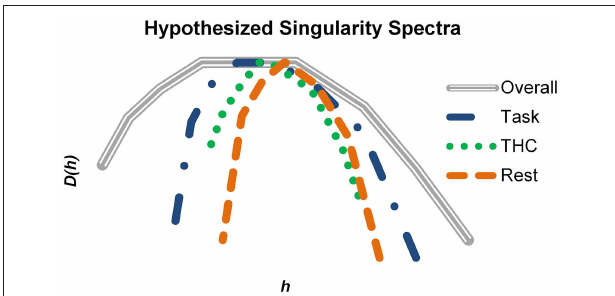
FIGURE 10 | Summary of how multifractal complexity relates to memory processing. Hypothetical singularity spectra were constructed based on the qualitative results of the study. The gray spectrum represents the maximal amount of multifractal complexity possible in a system (i.e., hippocampal spike trains in this example). Active memory processing recruits a large portion of this potential, but additional resources are still available to support more cognitively demanding instances. THC impaired working memory and reduced multifractal complexity. During resting conditions, the singularity spectrum shrinks compared to the task (blue) condition. Multifractality may be highest when embedded information relevant for working memory is being processed. Consequently, resting and pharmacological impairment could reduce multifractal complexity by decreasing the fraction of utilized